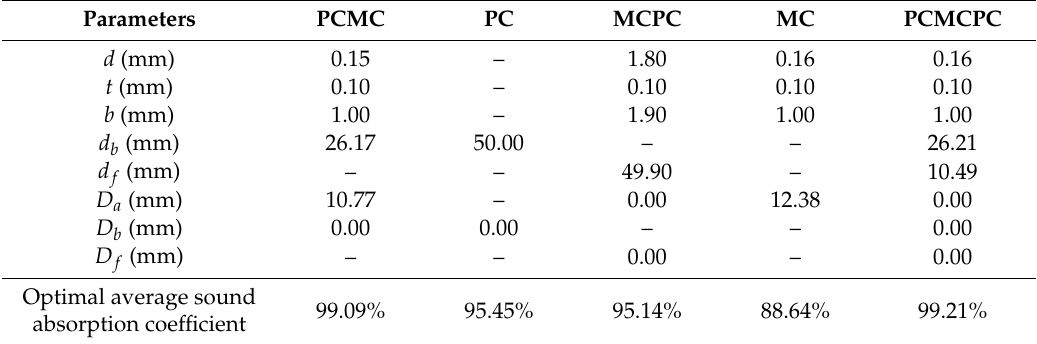
Table 4. Summarized optimal parameter of composite structure with limited total thickness 50 mm.